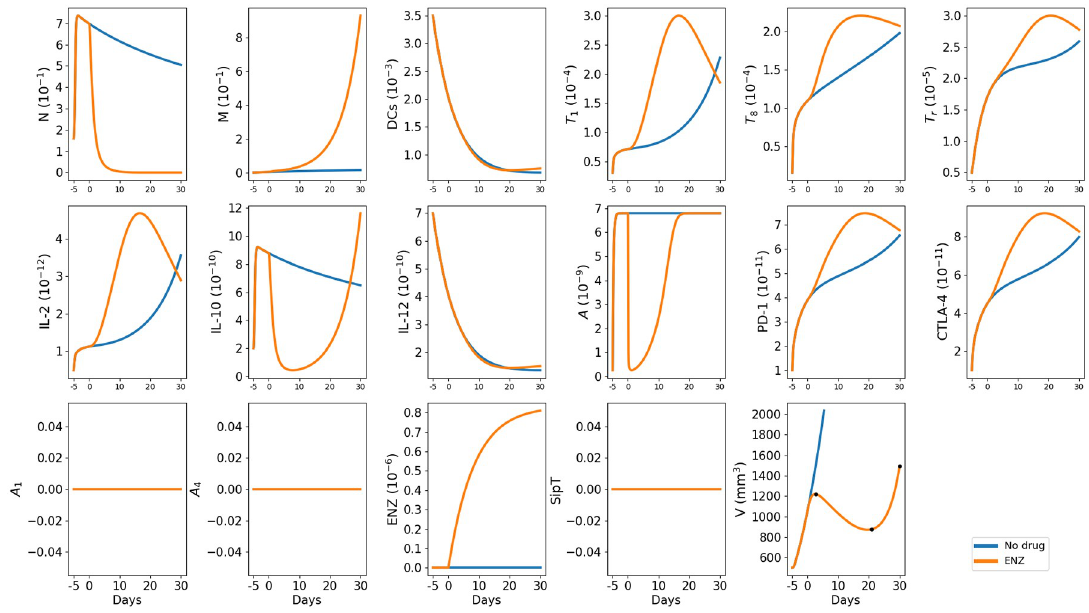
Fig 2. Simulation of the average densities/concentrations of the variables for model (2)–(21)with/without ENZ (ADT) at γ E = 10 − 7 g/cm 3 � d. The dots in the ‘V’ panel represent species’ tracking time points as shown in Fig 3. All parameters are as in S1 File Tables 1 and 2. The units of the variables are g/cm 3